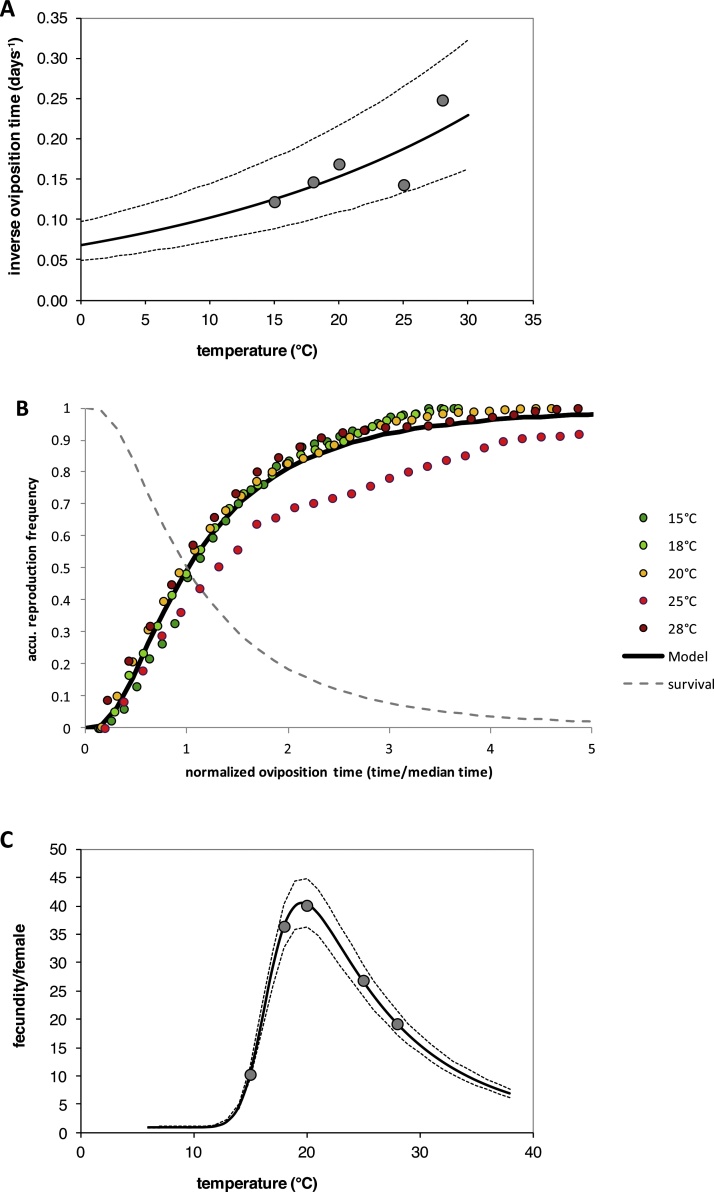
Fecundity of T. vaporariorum and its dependence on temperature and female age; (A) temperature-dependent inverse oviposition time (day−1) of T. vaporariorum females, (B) cumulative proportion of reproduction in relation to normalized female age, and (C) total fecundity per female. In A) and C) dots are observed data; solid lines are fitted models (exponential model in A and a parabolic model (see Table 5) in C); and broken lines are 95 % confidence limits for the fitted model. In B) colored dots are observed data (accumulated mean reproduction/total reproduction per female) at indicated experimental temperatures; bold line is the lognormal distribution model fitted to oviposition data, and the dashed grey line is the expected proportion of surviving females revealed from female survival data (for AFT models, see Table 4).